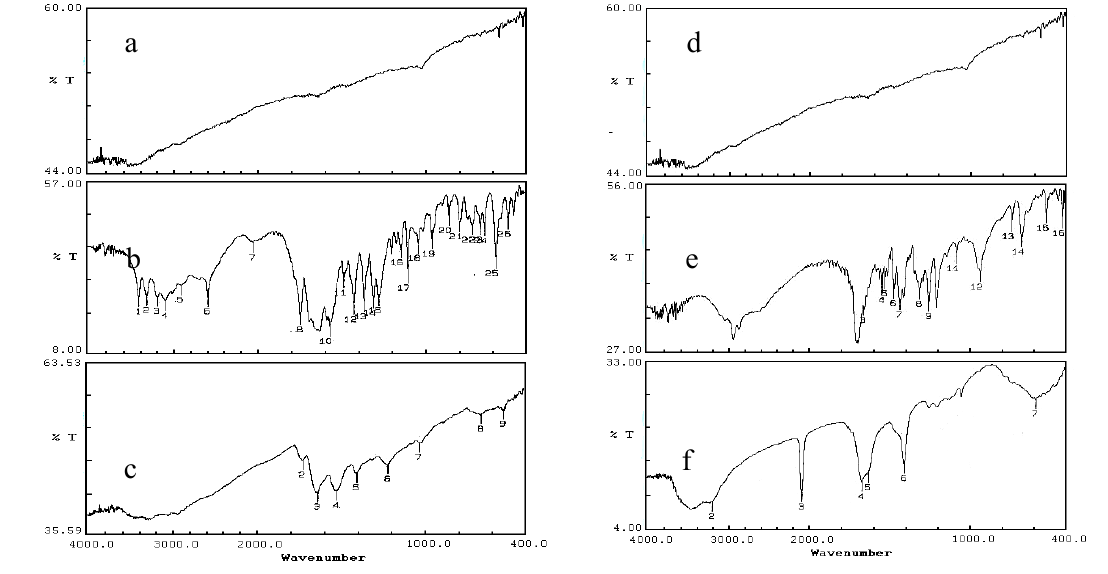
Figure 4. FT-IR (JASCO FT/IR-5300) spectrum in KBr of (a) gold nanoparticles, (b) glutathione powder and (c) gold nanoparticles capped with glutathione and (d) gold nanoparticles, (e) lipoic acid powder and (f) gold nanoparticles capped with lipoic